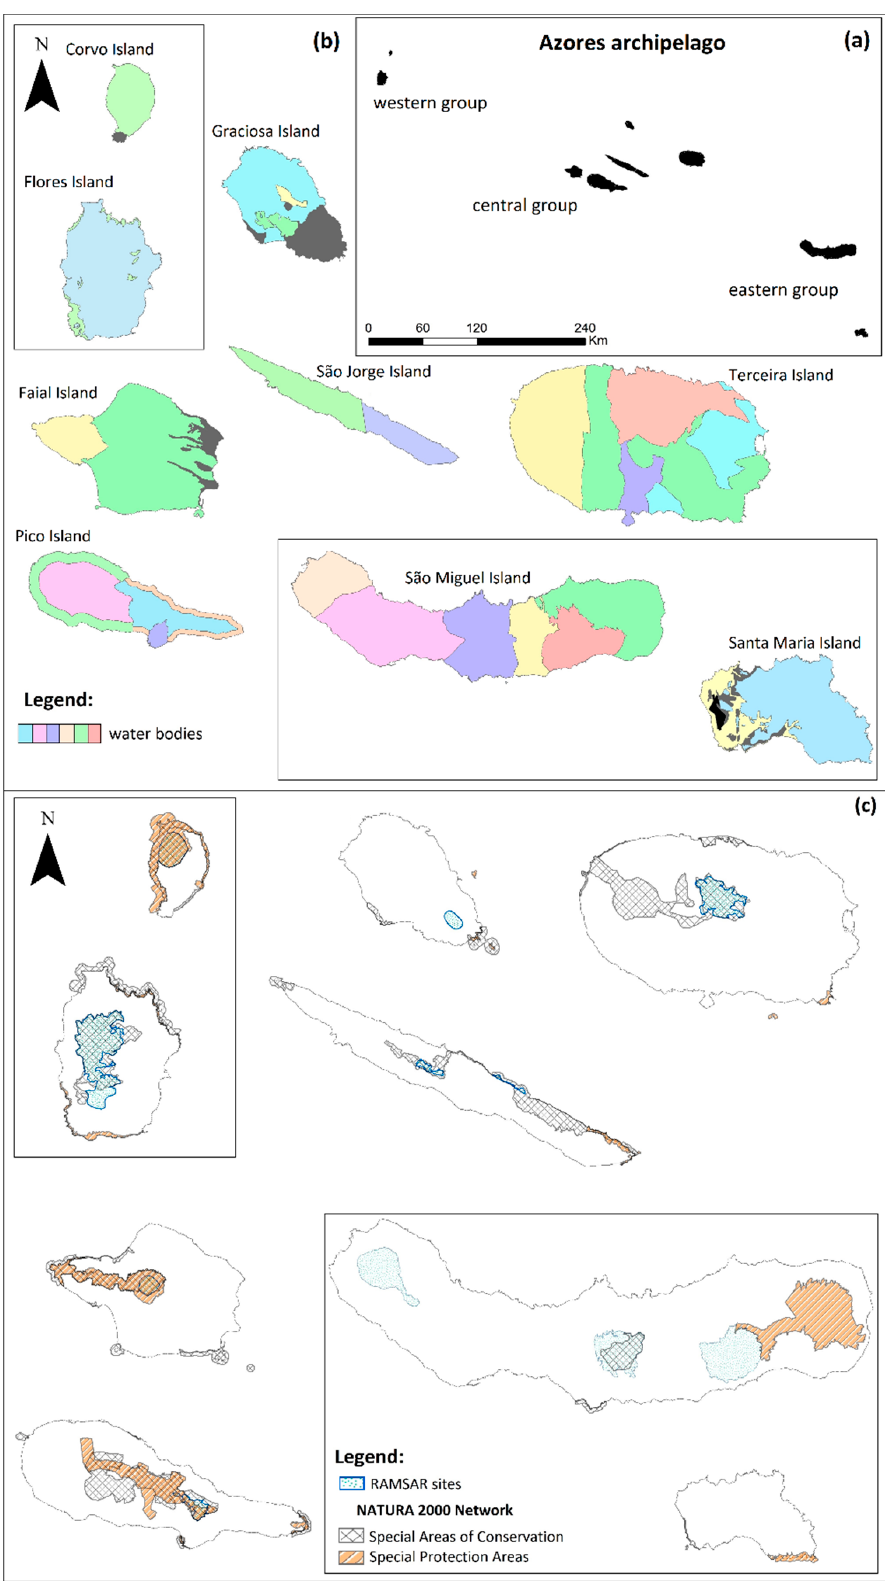
Figure 1. Mapping of the study area: ( a ) Azores archipelago vie; ( b ) groundwater bodies delimited in the Azores River Basin District; ( c ) Special Areas of Conservation and Special Protection Areas included in the Natura 2000 network.